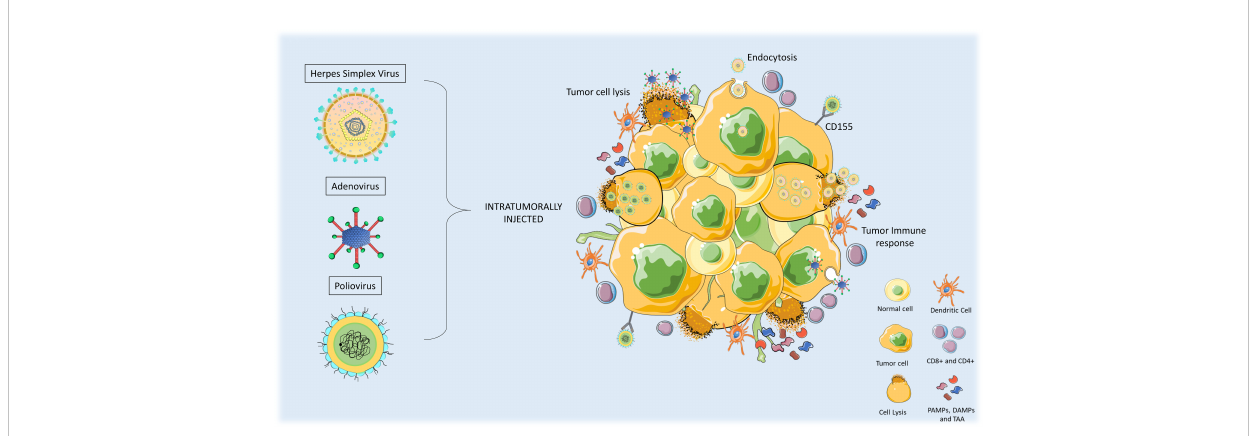
FIGURE 2 Anti-tumor mechanism of action of oncolytic viruses in high-grade gliomas (HGG). Oncolytic Viral therapies include genetic modi fi cations in the viruses. When administered intratumorally, the virus can infect normal and tumor cells but only replicates and lyse the tumor cells. Upon oncolysis, viral progenies are released that infect other tumor cells and release pro-immunogenic factors such as PAMPs, DAMPs, and tumor-associated antigens (TAA). Innate immune response triggers activation of antigen-presenting cells (APCs) and T-cells which leads to the induction of immunogenic cell death of tumor